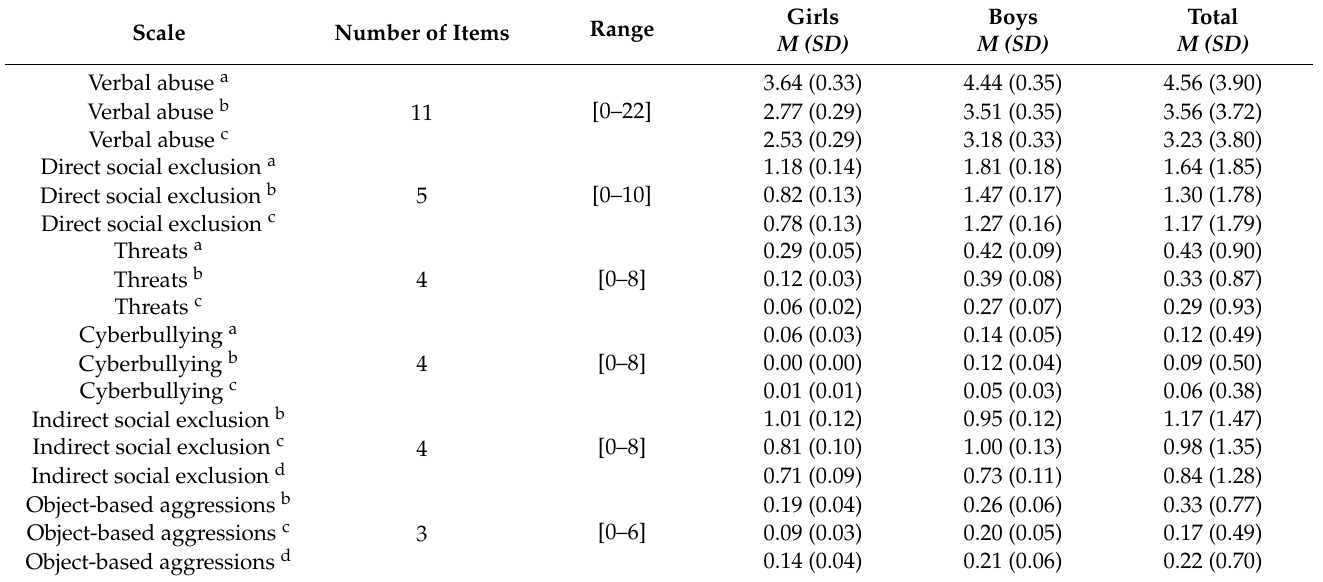
Table 1. Descriptive statistics of bullying behaviors in the pre-test, post-test, and follow-up a .